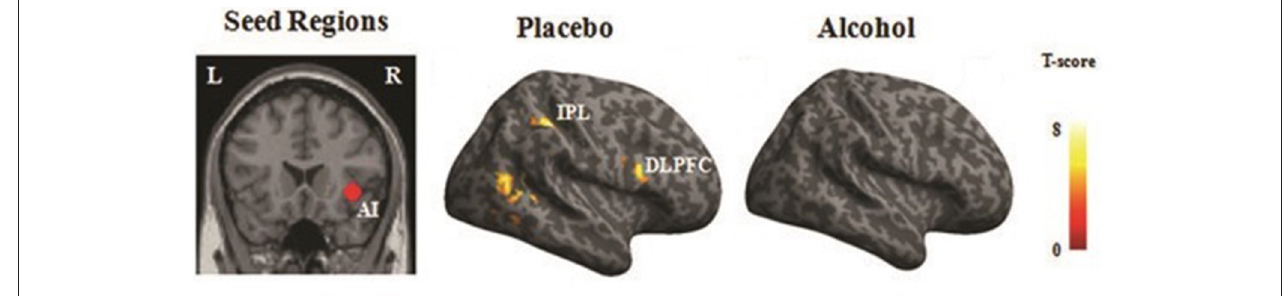
FIGURE 6 | PPI results. Regions that displayed increased functional connectivity with the right AI (rAI) during empathy for pain in the placebo and alcohol condition ( p < 0.001). The right hemisphere is displayed. L, left; R, right; AI, anterior insula; DLPFC, dorsal lateral prefrontal cortex; IPL, inferior parietal gyrus.